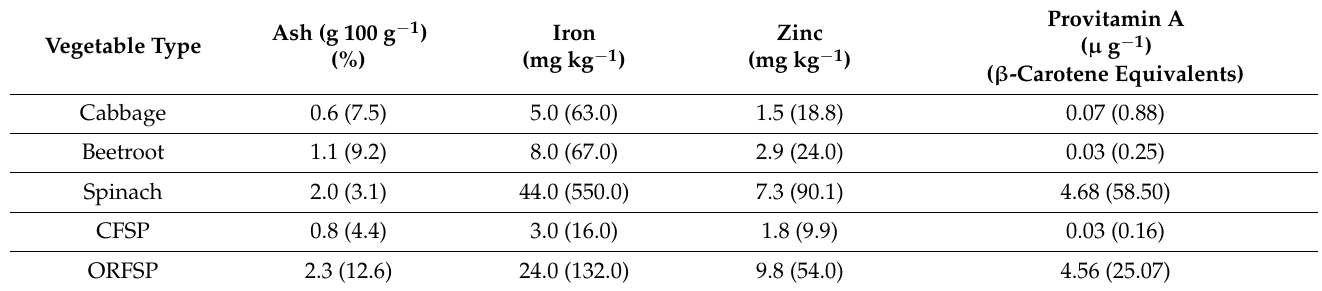
Table 2. The reference mean values for total mineral content (ash) and iron, zinc and provitamin A concentrations in different types of vegetables [14].